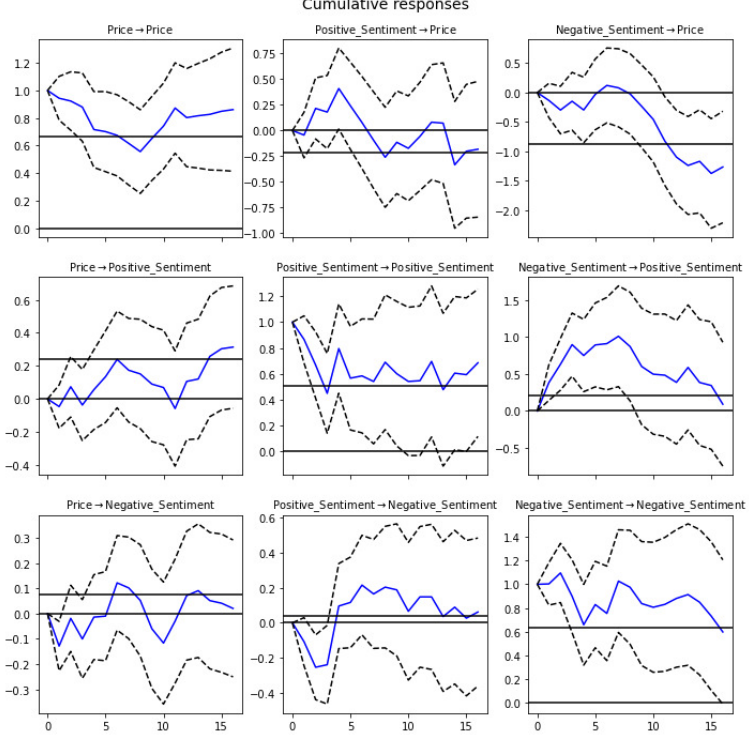
Figure 2. Cumulative effects plots from